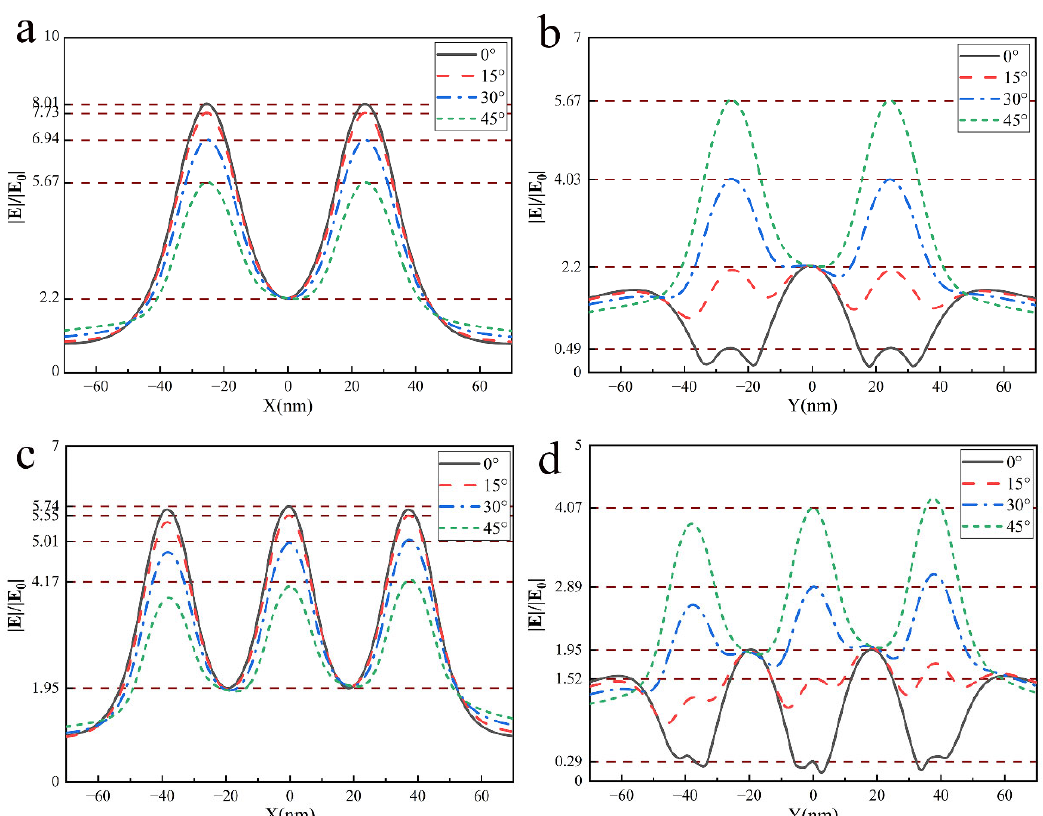
Figure 9. Enhancement factor curve at the dotted line in Figure 8 ( a ) x-direction of 2 × 2 array, ( b ) y-direction of 2 × 2 array ( c ) x-direction of 3 × 3 array, ( d ) y-direction of 3 × 3